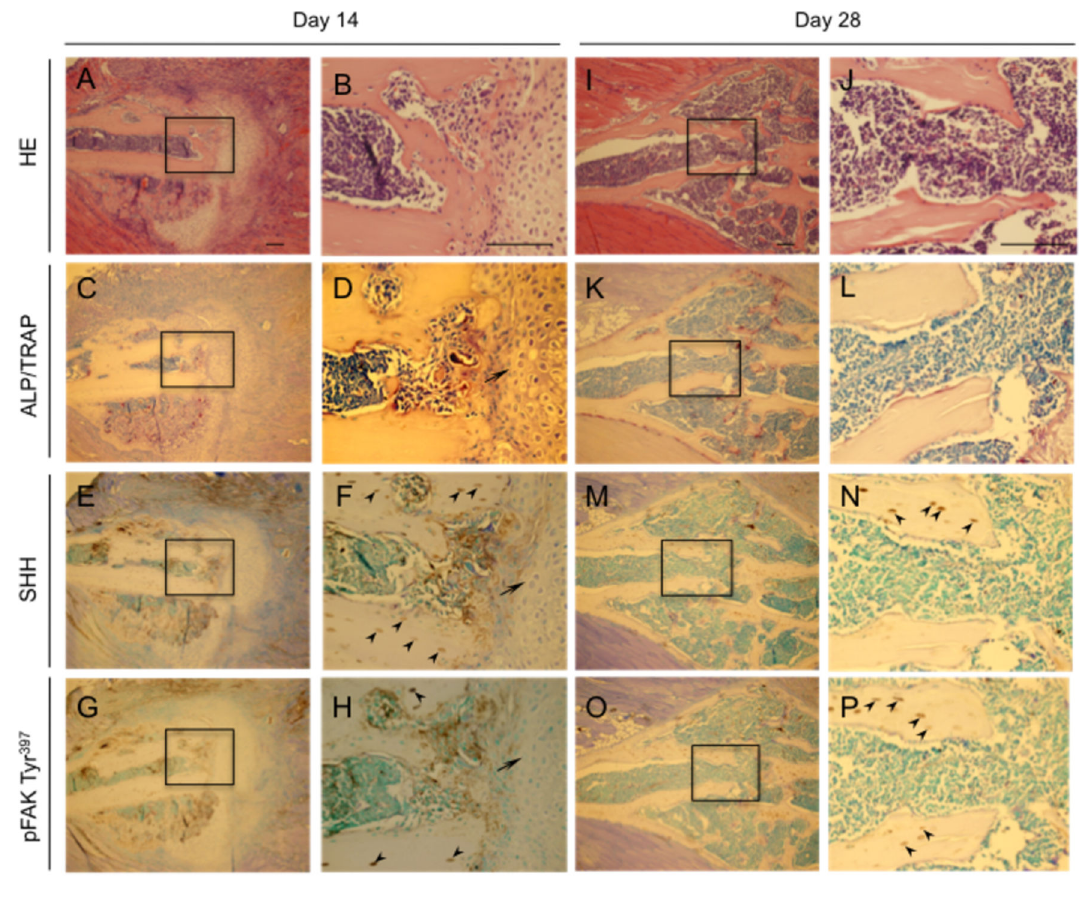
Figure 2. Histological appearance and localization of SHH and pFAK Tyr 397 in fractured mouse ribs at later stages after fracturing. Photomicrographs show the healing process at 14 (A-H) and 28 (I-P) after fracturing. Sections were stained with HE (A, B, I, and J) or for ALP and TRAP (C, D, K, and L), SHH (E, F, M, and N), pFAK Tyr 397 and (G, H, O and P). Each right photo is a magnification of the rectangle-delimited area in the corresponding left photo. Bar, 100 µm. Arrowheads: hypertrophic chondrocytes. Arrows: osteocytes. The data from a typical experiment are presented: similar results were obtained in repeated experiments. doi: 10.1371/journal.pone.0076785.g002 Figure 5E, microscopic observations and determination of the area occupied by migrating cells cultured for 36 h after scratching revealed that shFAK cells showed significantly suppressed migration compared with control and shcontrol groups. SHH did not significantly affect the migration of either control or that of shFAK#3 and shFAK#5 cells for 36 h (Figure 5F).